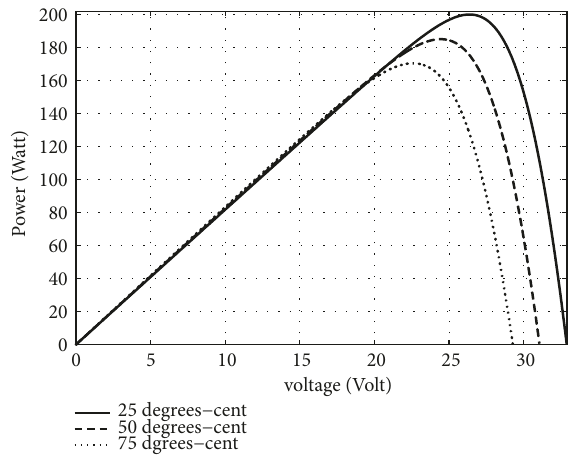
Figure 9: P–V model curves of the KC200GT solar module at different temperature, 1000W/m 2